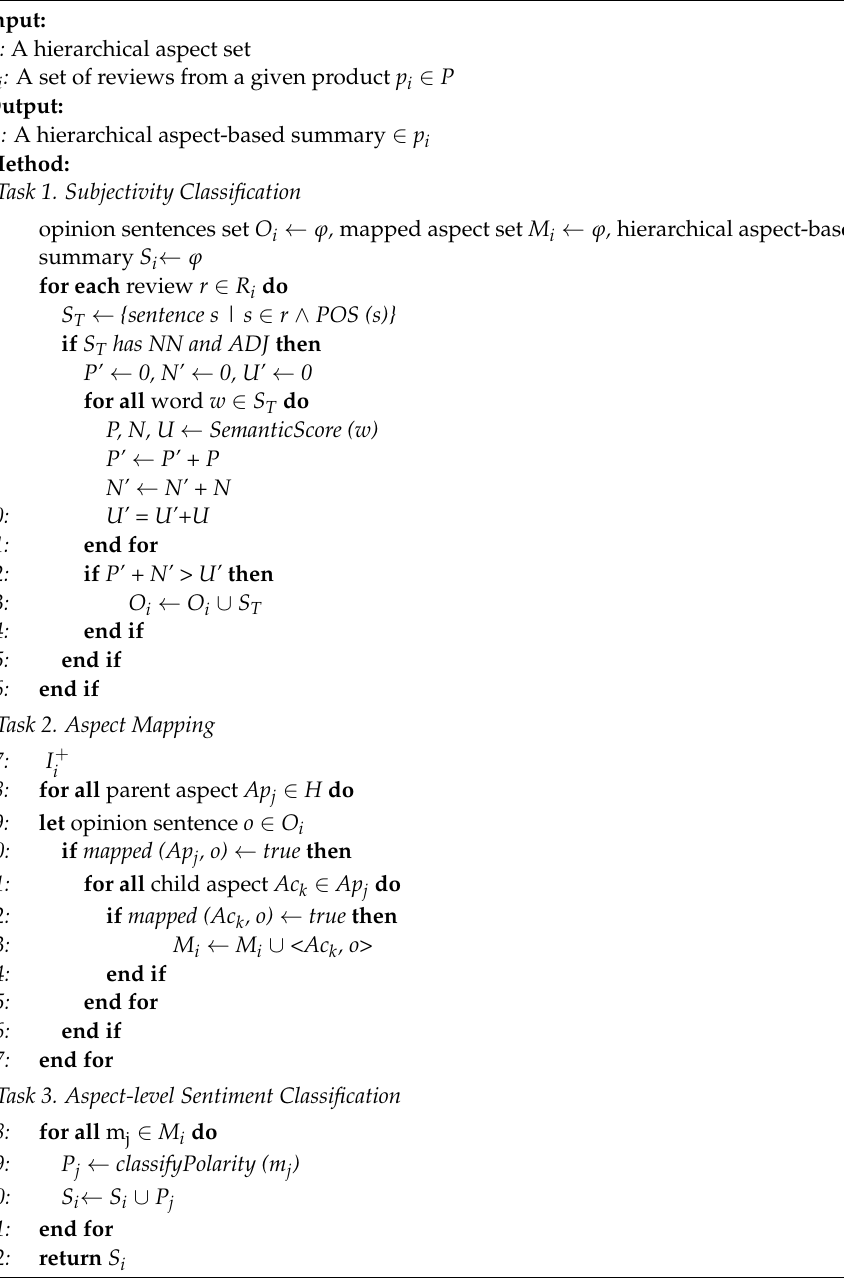
Algorithm 3. Hierarchical Aspect-Based Opinion Summarization (Phase